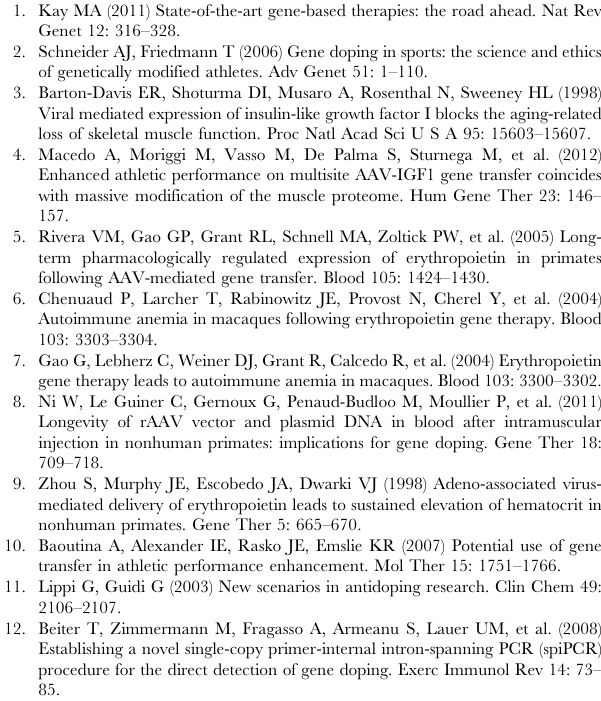
Figure S1 Standard curve, amplification plot and calculation for experimental estimation of IGF1 LOD and LOQ. Figure S2 PCR efficiency for undigested vs. digested IGF1 standards - Linearization of circular DNA leads to